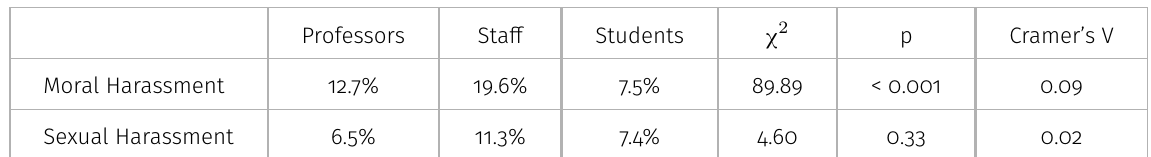
Table IV. Percentage of victims of harassment who had reported it. The last three columns are χ 2 tests, p-values, and Cramer’s V for effect